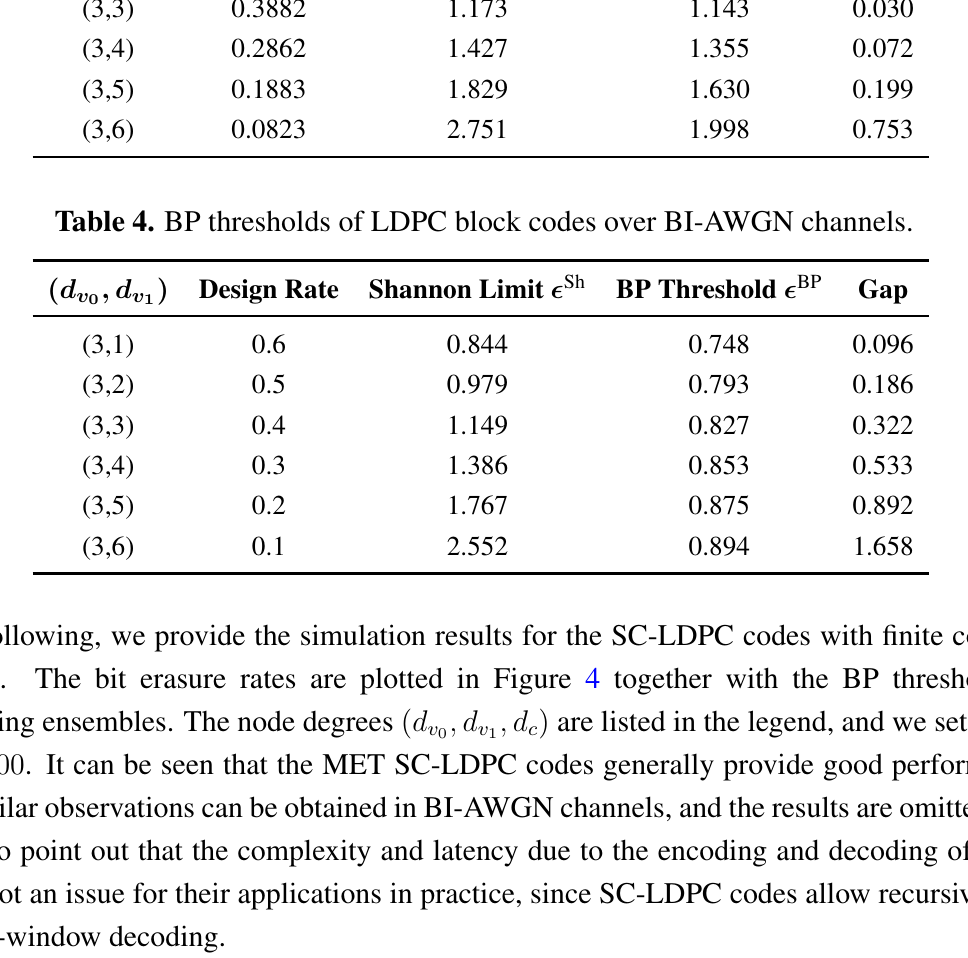
Table 3. BP thresholds of C